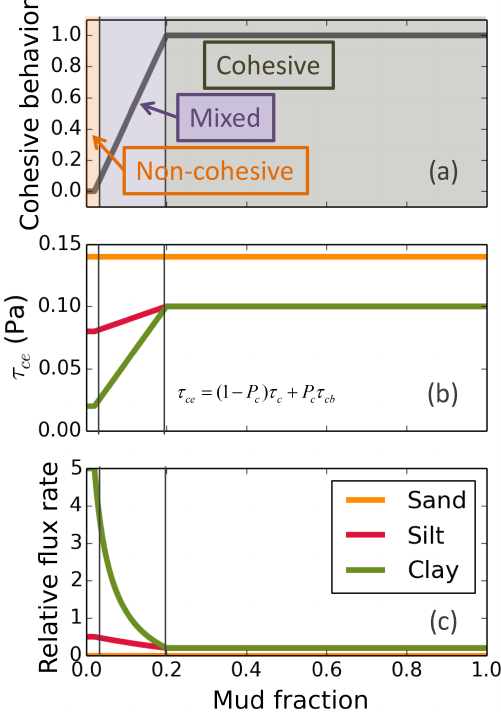
Figure 2. Summary of mixed-bed behavior with increasing mud fraction f c (the combined mass fraction of material in cohesive classes). (a) Cohesive behavior parameter P c as a function of f c . (b) Effective critical shear stress τ ce for size classes in which the bulk critical shear stress of the bed τ cb = 0 . 1Pa. (c) Relative flux (normalized excess shear stress) from the bed when bed stresses are ∼ τ = 0 . 12Pa (greater than τ c for clay and silt primary particles, b but less than τ c for